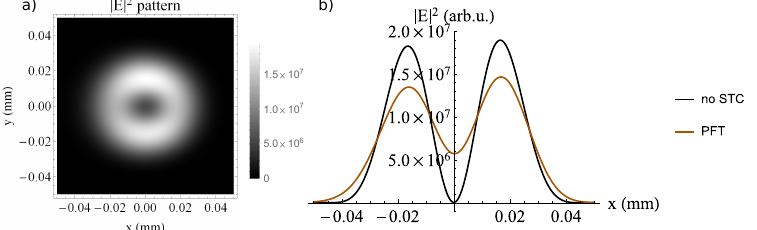
2 ) on xy of the laser field with PFT = 0.8 fs/mm in E | |